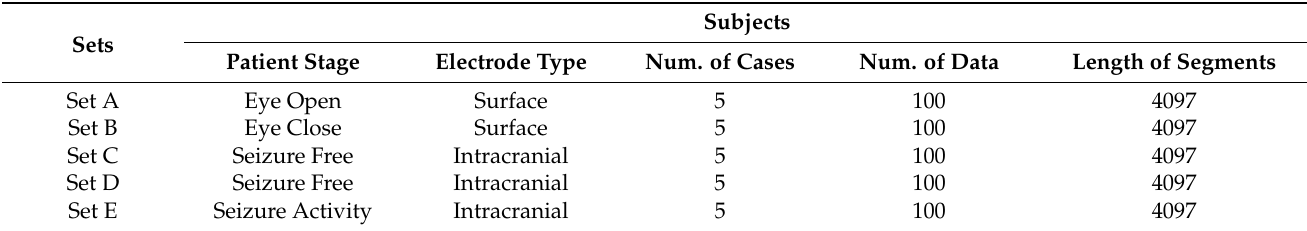
Table 1. A thorough explanation of the five subsets of the